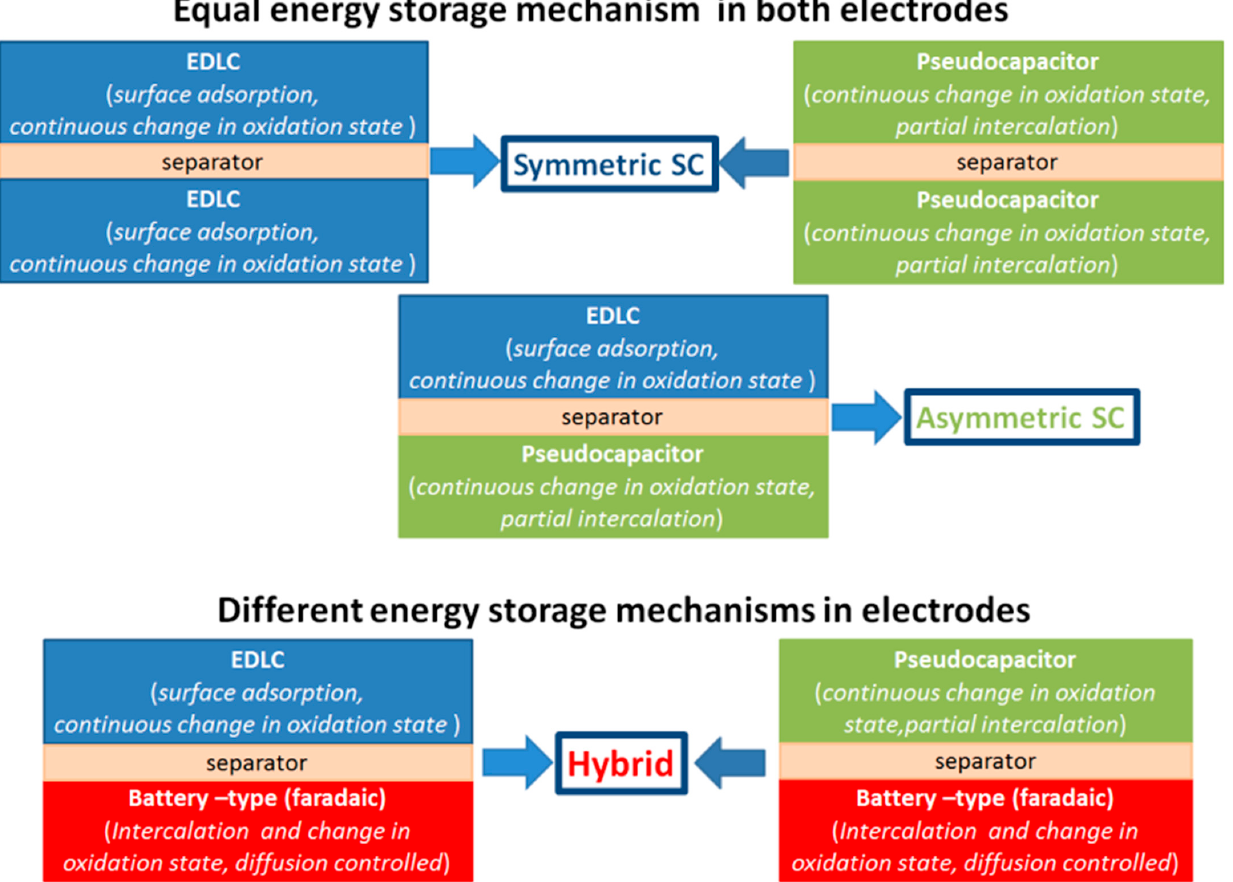
Figure 4. Schematic view of possible combinations of electrodes and final devices fabricated on them.